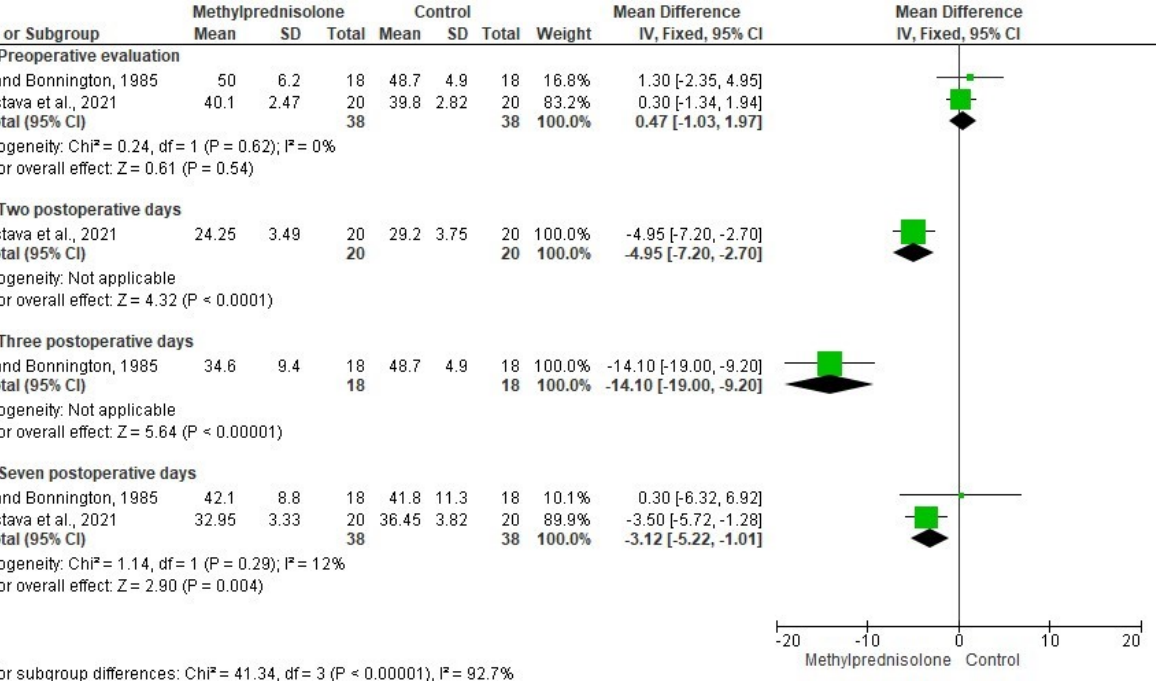
Figure 4. Pooled analysis of the anti ‐ trismus effect ( p < 0.05) [29,30].